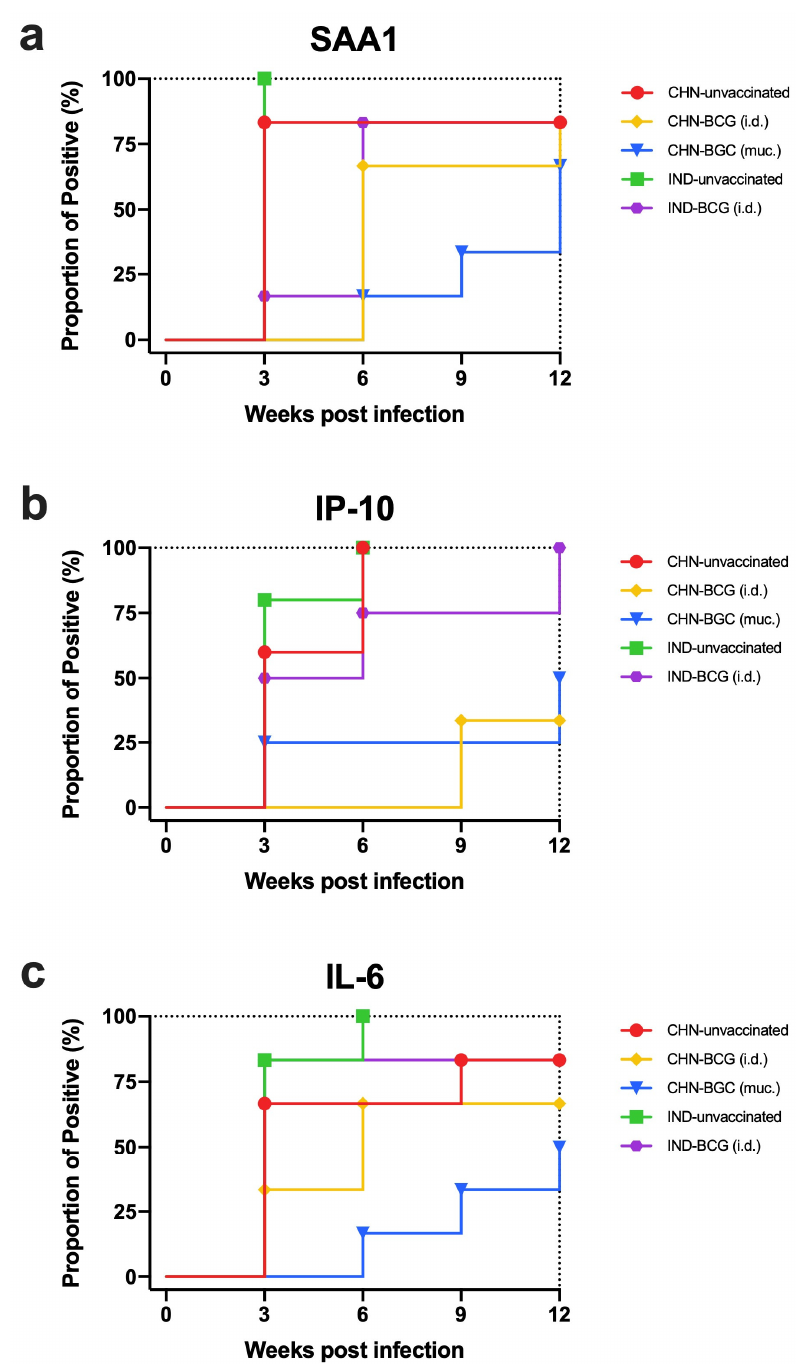
Figure 4. SAA1, IP-10, and IL-6 levels in two rhesus genotypes with/without BCG vaccination after MTB infection. SAA1, IP-10, and IL-6 levels were measured by UCP-LFA in serum from high-dose (500 CFU) MTB Erdman infected Chinese-type (CHN, n = 18) and Indian-type (IND, n = 12) rhesus macaques. 12 macaques were unvaccinated (CHN, n = 6, red dots; IND, n = 6, green squares); 18 were vaccinated with BCG 17 weeks before infectious challenge with MTB, of which 12 by intradermal injection (BCG i.d.; CHN, n = 6, yellow rhombus, and IND, n = 6, purple hexagons) and 6 by pulmonary mucosal administration (BCG muc; CHN, n = 6, blue triangles)) ( a – c ) Kaplan–Meier curves were plotted, showing the proportion of positive NHP over time for the Chinese vs. Indian rhesus macaques with/without BCG vaccination.